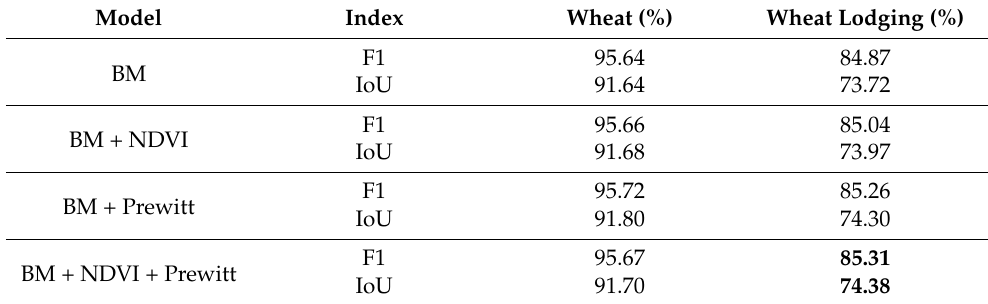
Table 8. Segmentation results of the ablation